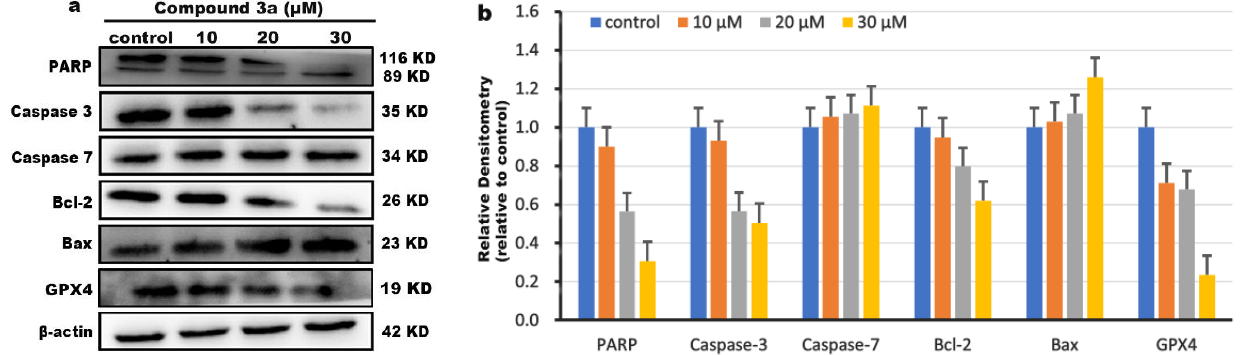
Figure 10. ( a ) The expressions of PARP, Caspase-3, Caspase-7, Bcl-2 and Bax, and GPX4 were deter- mined using western blotting assay. β-actin was used as a reference control. ( b ) Quantitative analy- sis of protein expression of PARP, Caspase-3, Caspase-7, Bcl-2 and Bax,